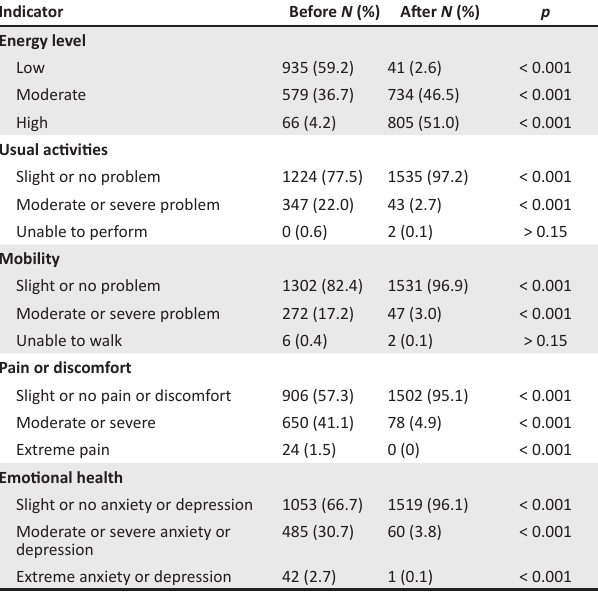
TABLE 6: Medication use before and after low-carbohydrate diet initiation. Medication type